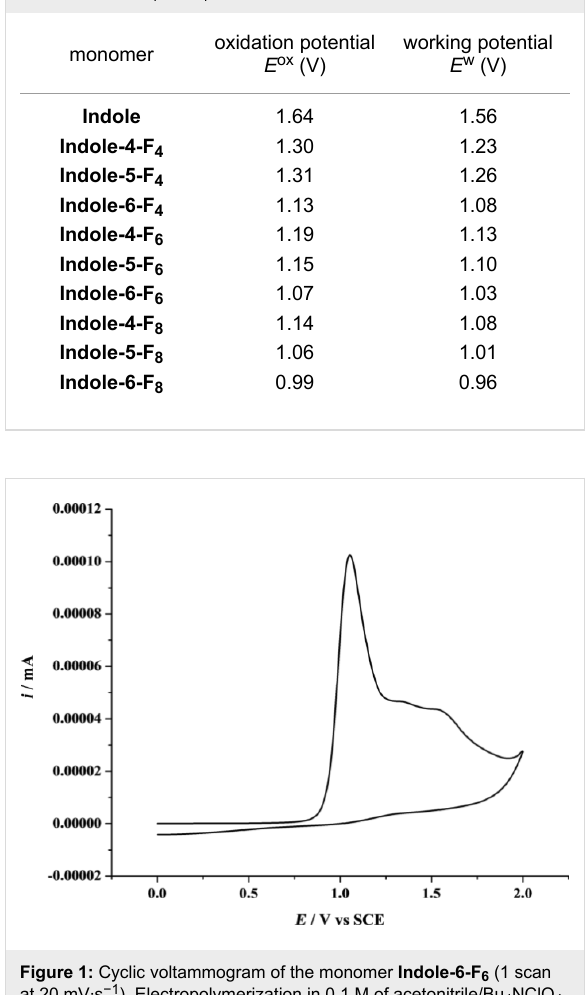
Table 1: Oxidation potential ( E ox ) and working potential ( E w ) for each monomer by electrochemical process. Electropolymerization in 0.1 M of acetonitrile/Bu 4 NClO 4 .